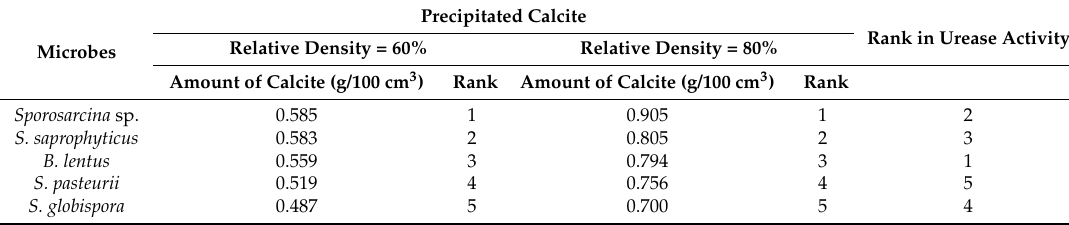
Table 2. Microbe ranking based on the amount of calcite and urease activity.